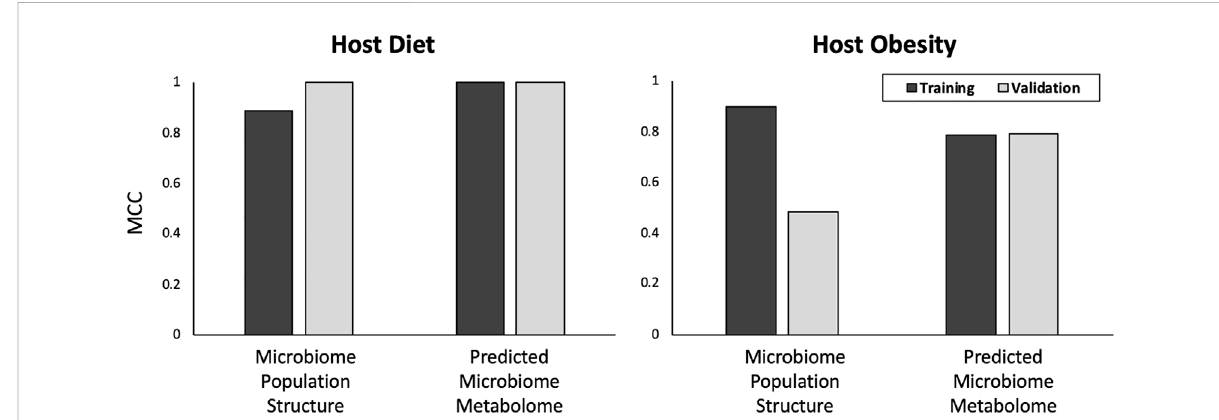
FIGURE 3 Predict microbiome enzyme function pro fi les from community structures. On x-axis is the two modeling approaches considered: “ Initial Prediction ” and “ Optimized Prediction ” Y-axis is the average PCC between predicted and observed mouse gut EFPs. Error bars are +/ − one standard deviation.